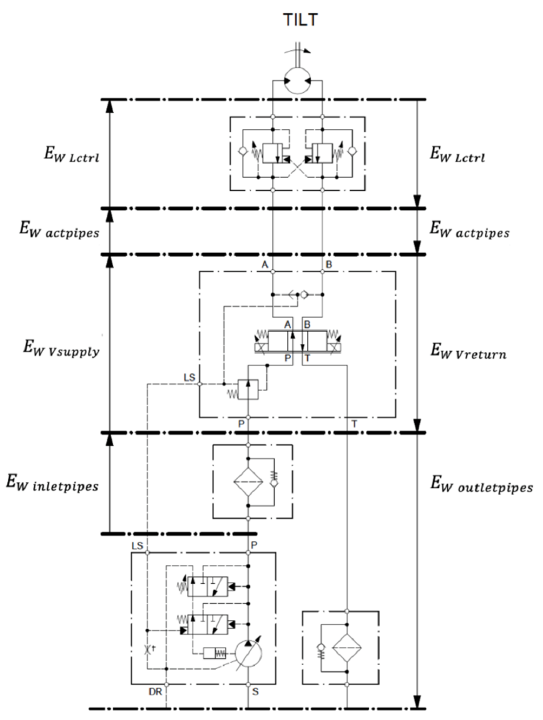
Figure 5. Grouped energy losses for the tilt actuator.